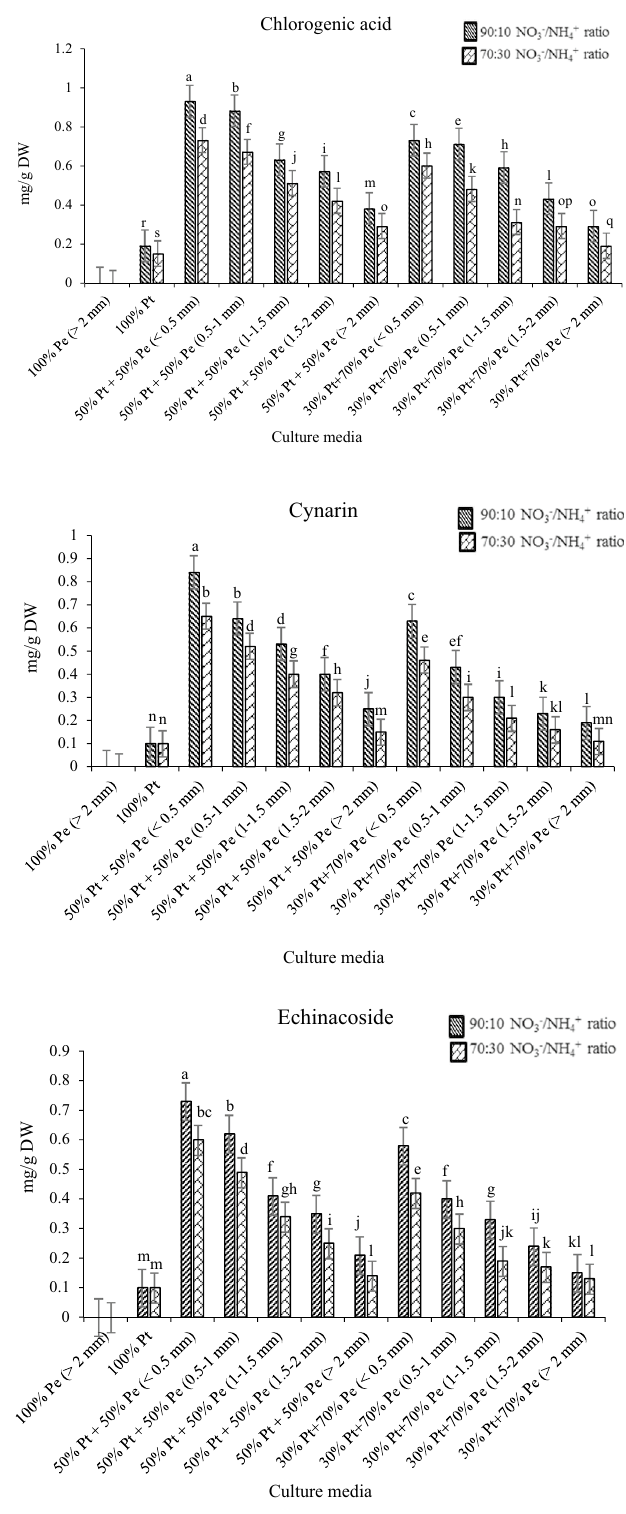
Figure 4. Caffeic acid derivatives of E.purpurea root at different culture media and NO 3− /NH 4+